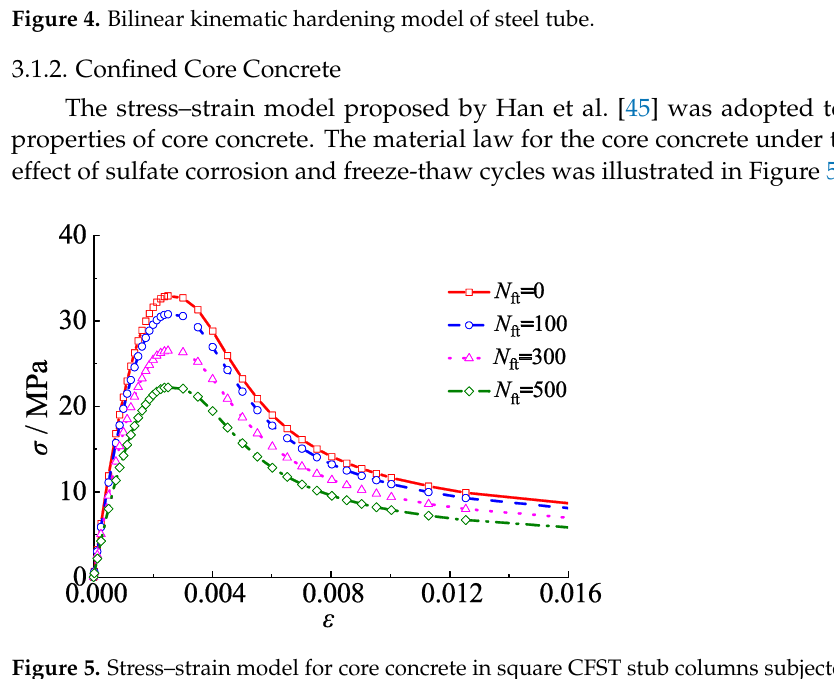
Figure 5. Stress–strain model for core concrete in square CFST stub columns subjected to alternating sulfate corrosion and freeze-thaw cycles.